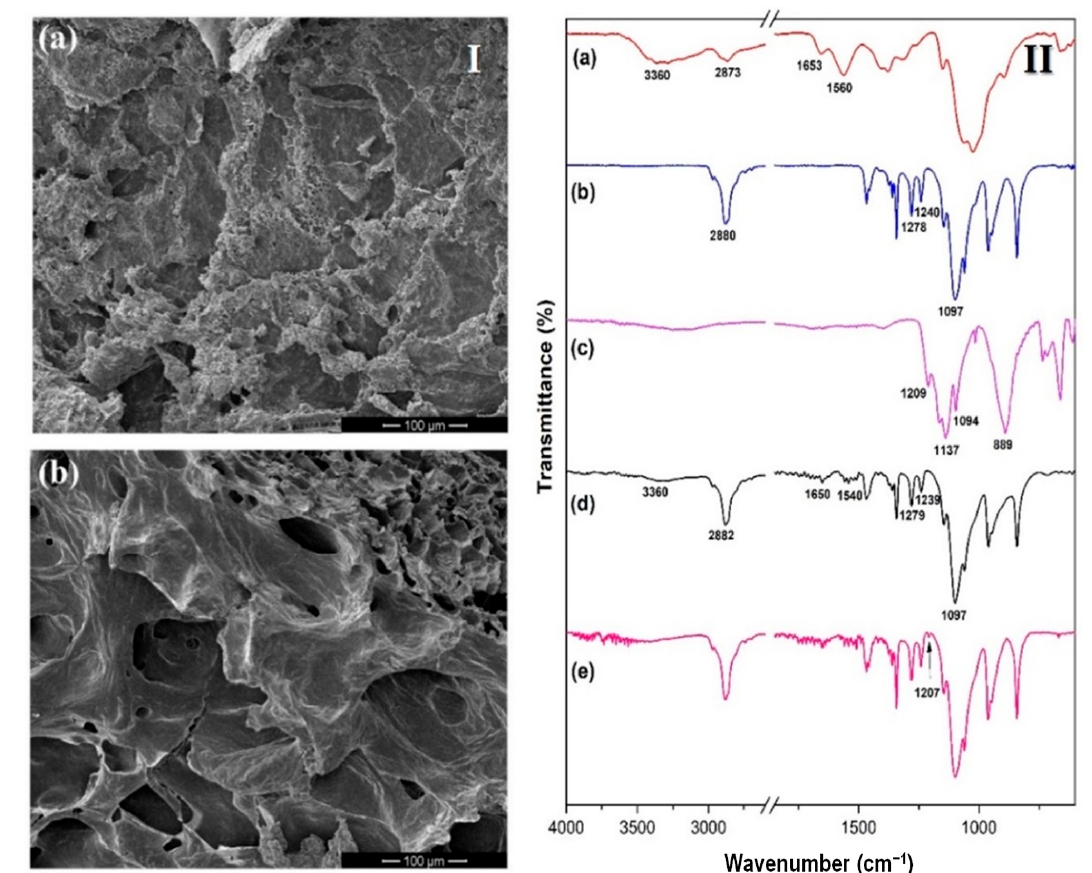
Figure 2. ( I ) SEM micrographs of freeze-dried hydrogels, CS1-PF25 ( a ) and CS-PF-TPP ( b ). ( II ) FTIR spectra of CS ( a ), PF 127 ( b ), TPP ( c ), CS-PF hydrogel, and CS-PF-TPP hydrogel (( d , e ), respectively).